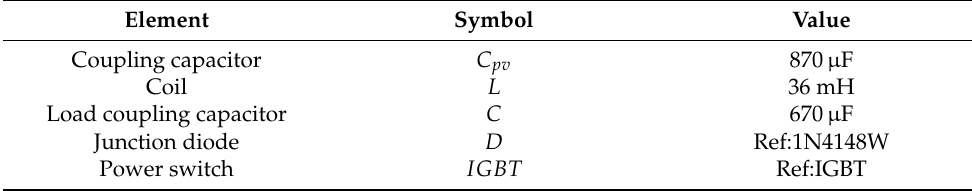
Table 2. DC/DC converter element table.